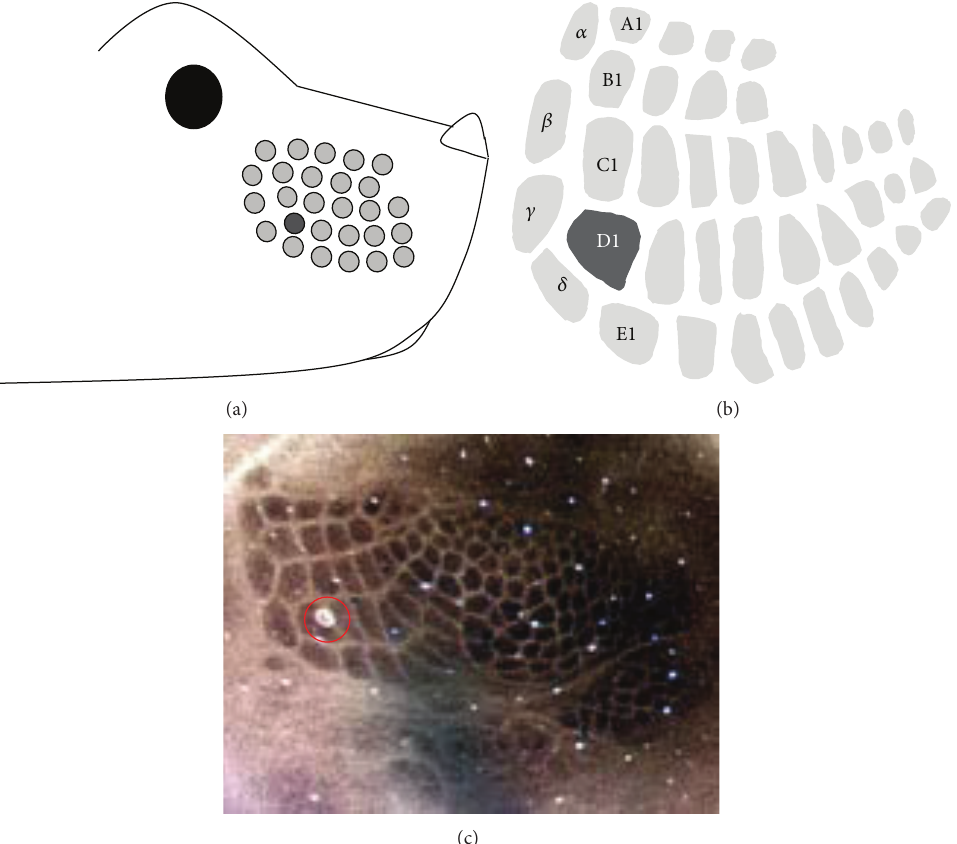
Figure 1: The murine whiskers have a corresponding somatotopic representation in the cortex. The location of the whiskers on the mouse’s snout is shown in (a), with the corresponding barrels labelled in (b). The murine barrel field (cortical layer IV) was stained for cytochrome oxidase histochemistry (c). The lesion (red circle) was made by passing a small current through a carbon fibre electrode and indicates the D1 barrel. The somatotopic arrangement of barrels provides an excellent reference point for plasticity experiments by the removal of whiskers.